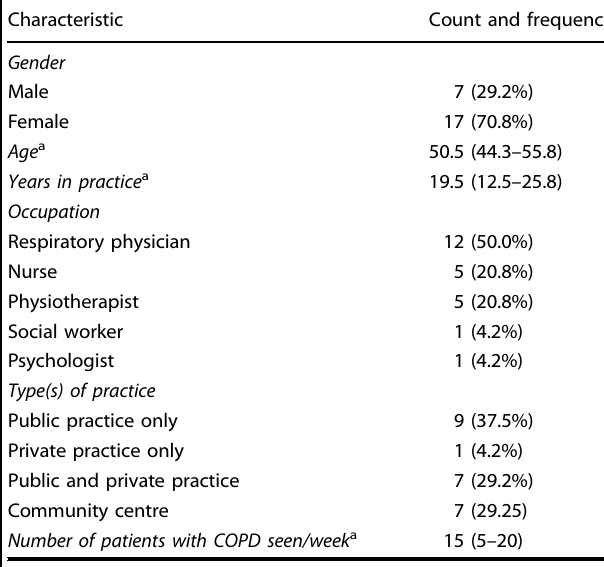
Table 1. Participants ’ characteristics ( n =